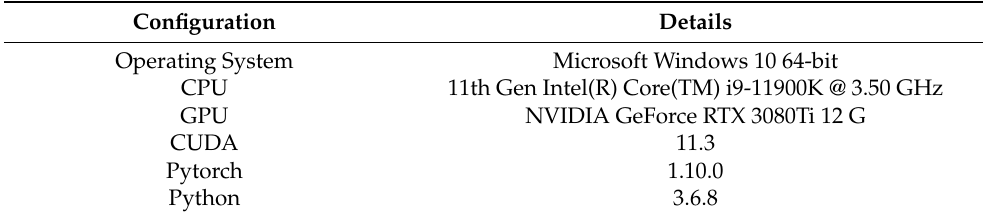
Table 1. Configurations of the model training